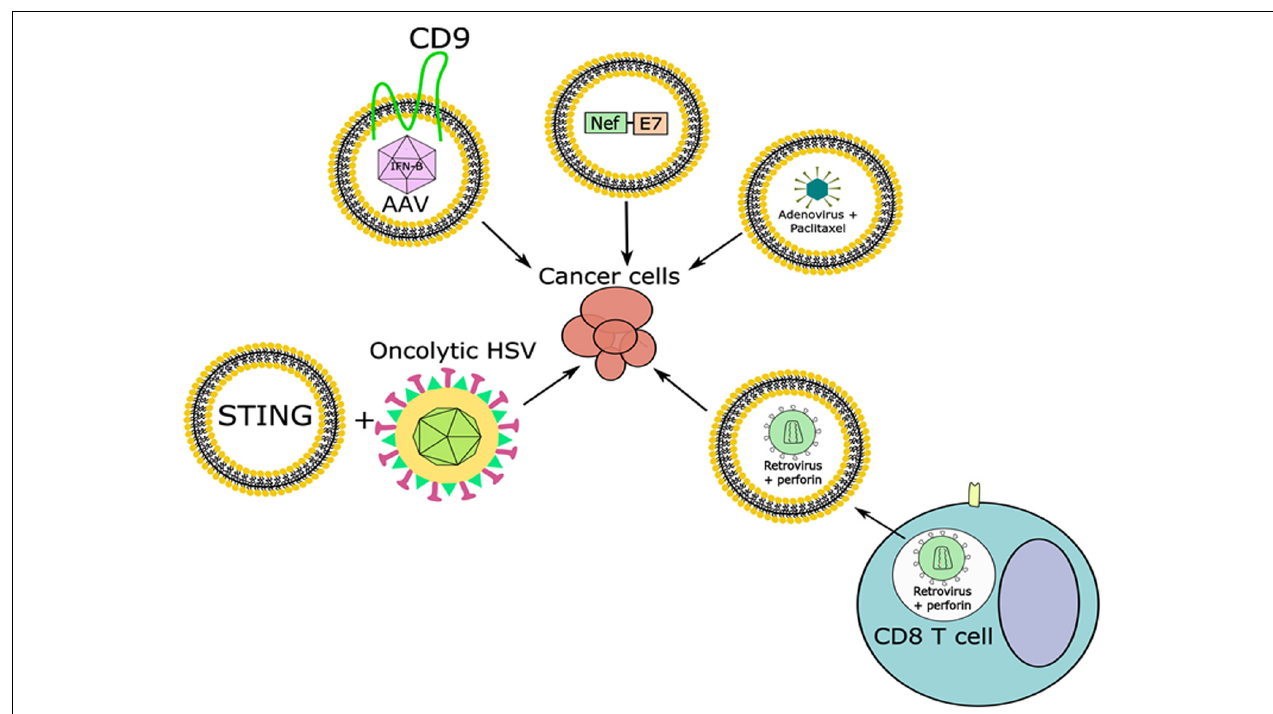
FIGURE 5 | Combining EVs carrying viruses or viral factors along with viral infection to combat cancer. Adenoviruses, some retroviruses, and AAV have been found in endosomes or EVs and can be used, alone or in combination with other factors, to target cancer cells. Viral proteins can also be packaged in EVs and used for the treatment of cancer, while oncolytic viruses could be combined with EVs containing anti-tumor factors to target cancer